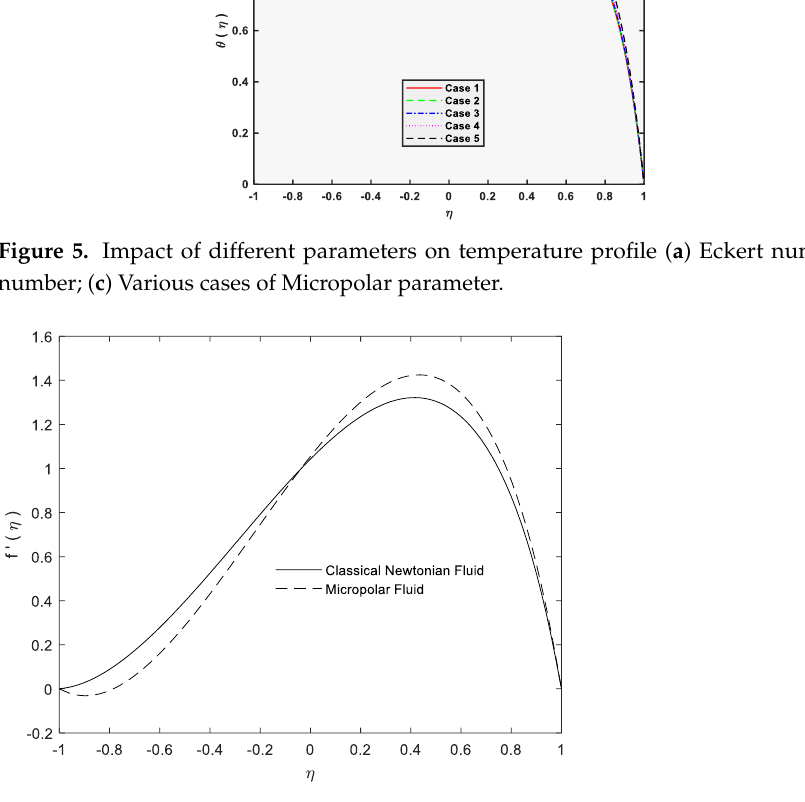
Figure 6. Velocity distribution across the channel for Newtonian and micropolar fluids for Re = 5, M = 0, A = 1.5, C 1 = 0.1, C 2 = 1, and C 3 =